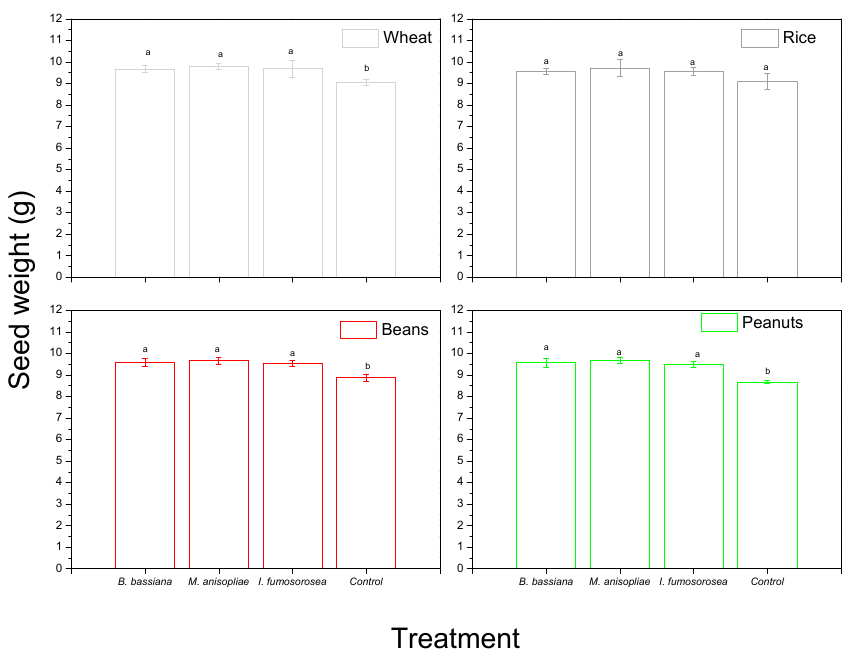
Figure 3. Seed weight (g ± SD) of wheat, rice, beans and peanuts treated with 10 8 spores mL − 1 of B. bassiana (strain name: GBBSTTS), I. fumosorosea (strain name: RHZ4RAS) and M. anisopliae (strain name: Z3RAS), after infestation with E. kuehniella larvae for 10 days.